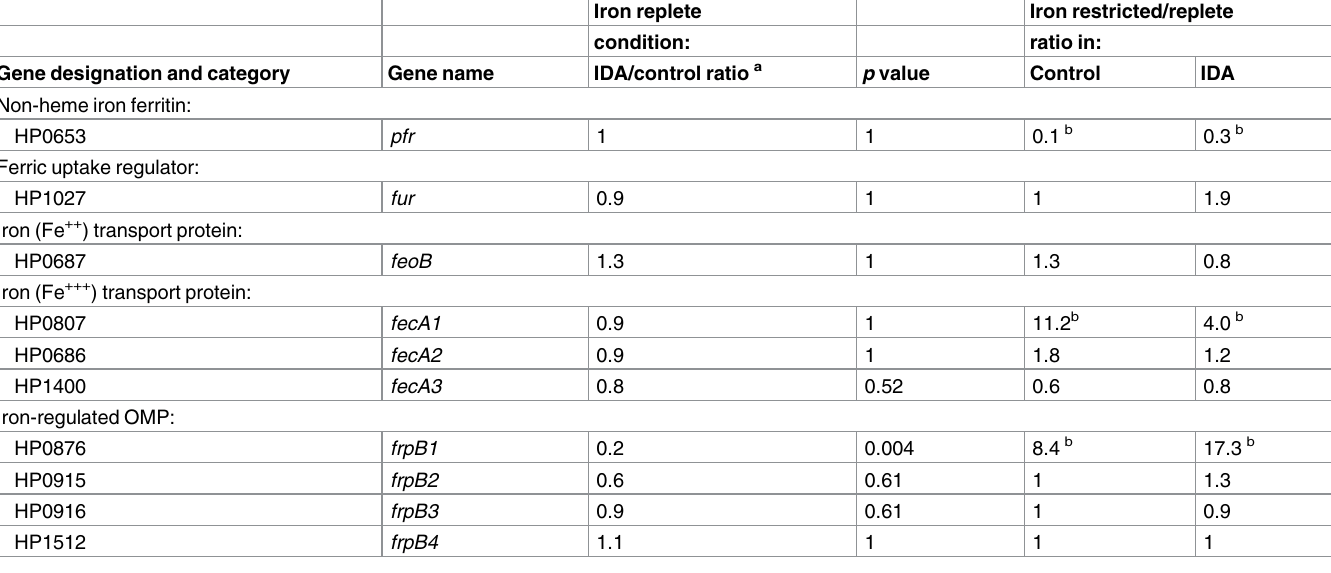
Table 2. Expression of H . pylori genes known to be related to iron